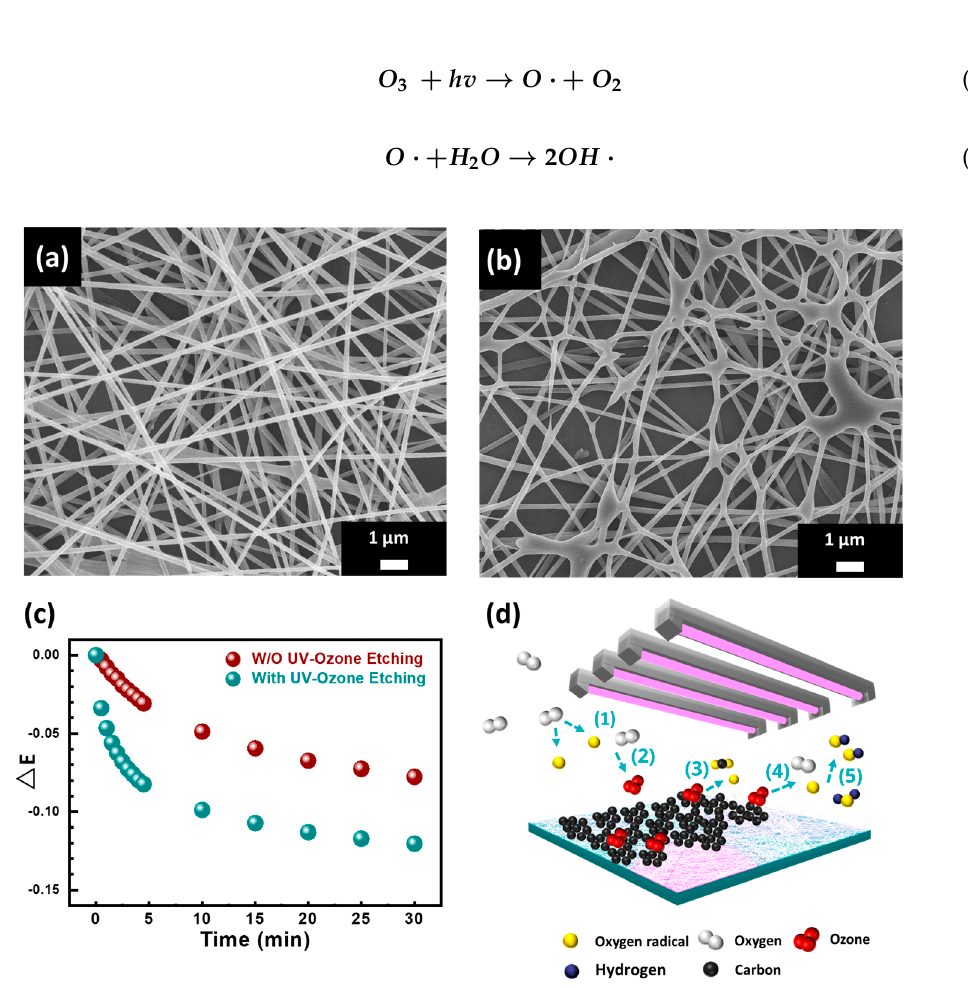
Figure 4. SEM images of WO 3 /SnO 2 /Ag/PMMA with UV − ozone etching: ( a ) non − etched and ( b ) 10 min etched. ( c ) Extinction changes of WO 3 /SnO 2 /Ag/PMMA sensing materials with and without etching when exposed to 10,000 ppm acetone. ( d ) Schematic diagram of UV–ozone etching process.